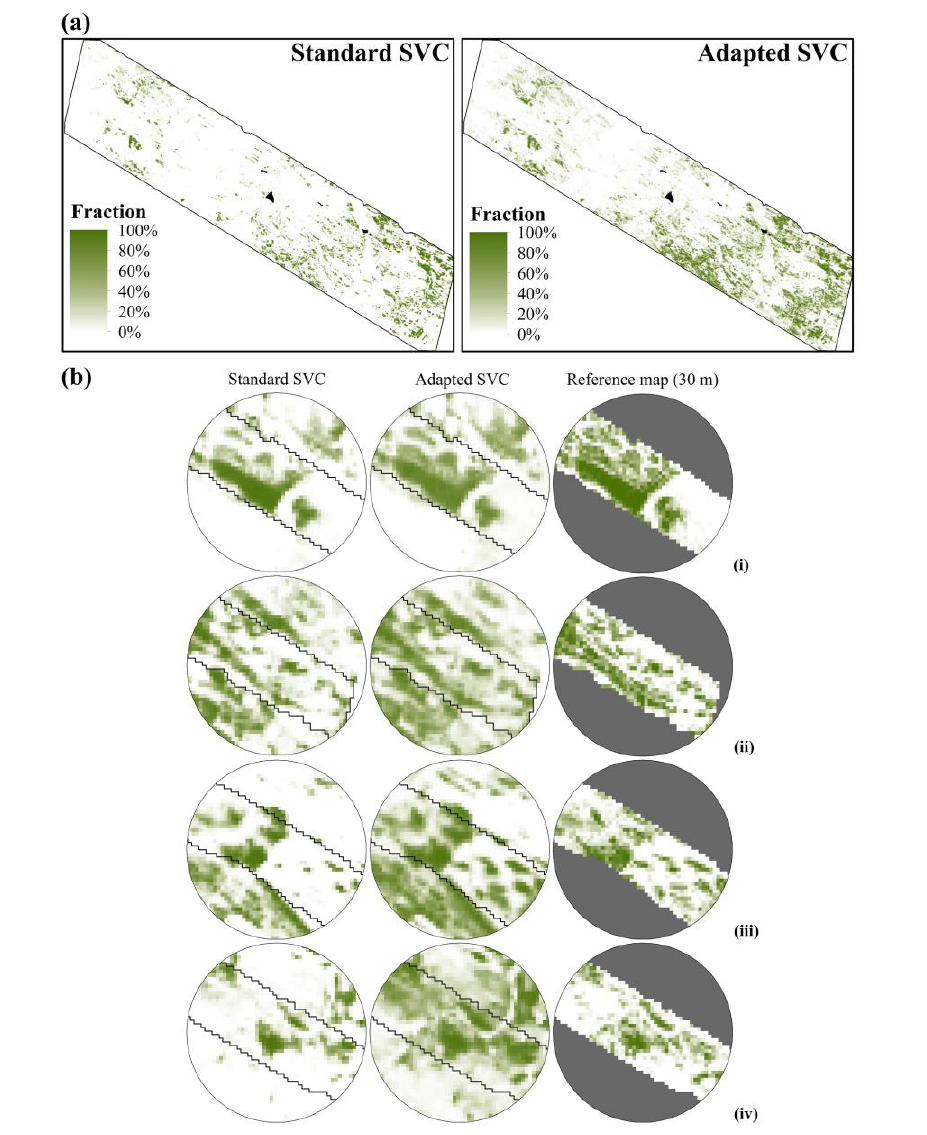
Figure 4. Shrub cover fraction maps derived from standard SVC and adapted SVC ( a ) for the entire study area and ( b ) for selected subsets. For information on coordinates and orientation, the reader is referred to Figure